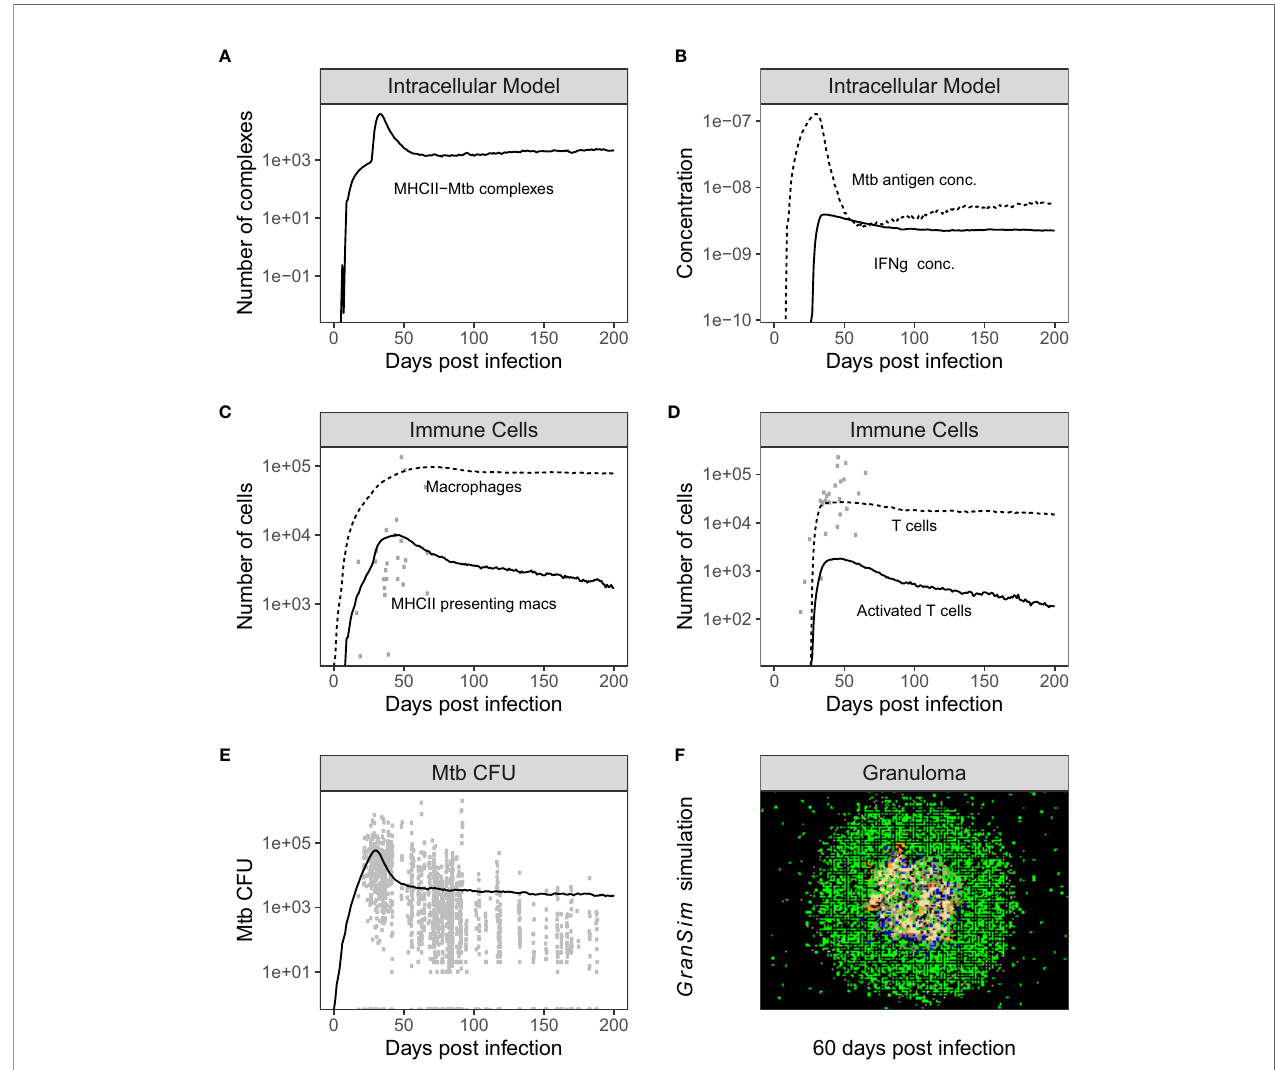
FIGURE 3 | Simulation output is consistent with NHP data. Time series plots showing the dynamics of both individual model outputs from the combined Multi-scale model. Panels (A, B) shows the variables in the intracellular model over time, and Panel (C, D) show the time series of total populations of immune cells [shown together with non-human primate (NHP) datasets from Wessler et al. (67)]. Panel (E) shows the CFU [shown together with NHP data sets from Wessler et al. (48)] and Panel (F) is a time series snapshot at day 60 of the Multi-scale GranSim granuloma model, 2x2 mm scale. Cell types in Panel (F) : Macrophages: resting (green), active (blue), infected (orange), chronically infected (red); T cells: Mtb-speci fi c (dark pink), non Mtb-speci fi c (light pink); caseation (tan); extracellular bacteria (dark